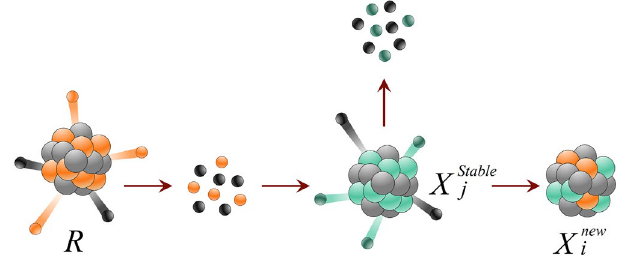
Figure 7. Procedure of β -decay in a stable nucleus.